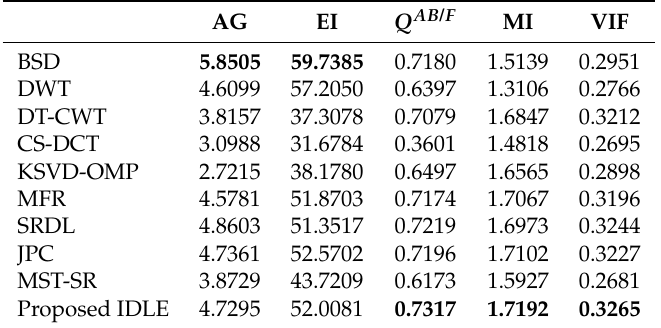
Table 3. Objective Evaluations of MRI-SPECT Image Fusion Comparative Experiments.